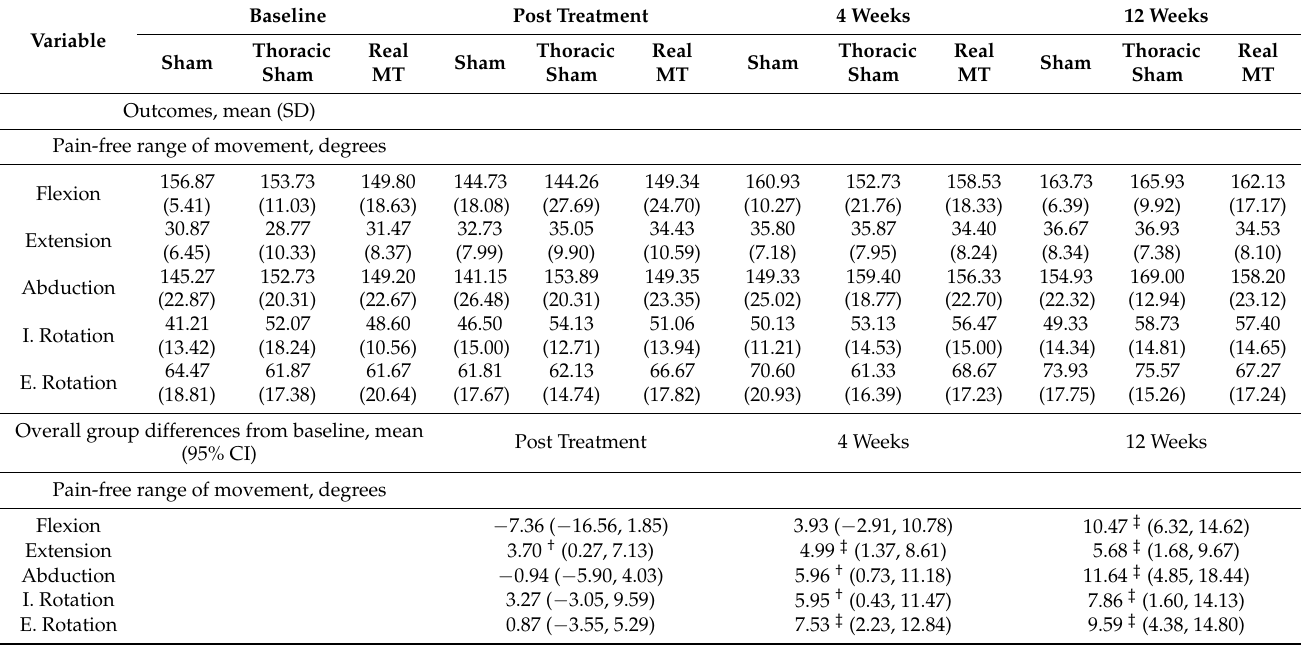
Table 3. Range of movement differences from the